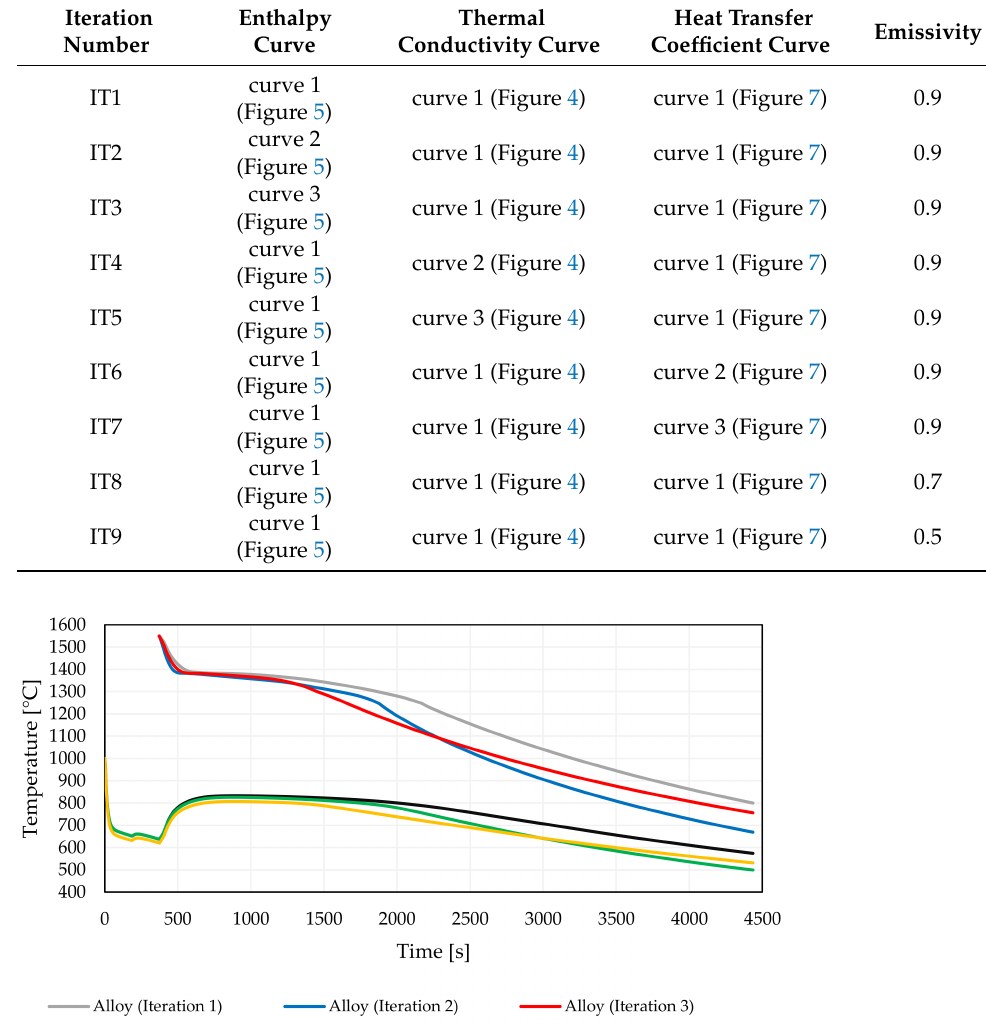
Table 4. Set of iterations to evaluate the influence of enthalpy, thermal conductivity, heat transfer coefficient, and emissivity parameters.